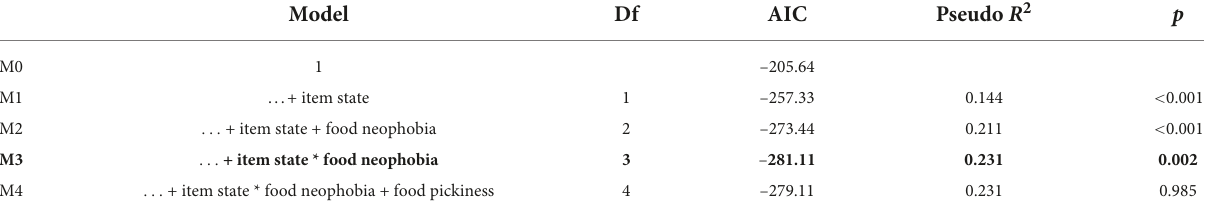
TABLE 6 The goodness of fit of the linear mixed-effects models with Beta as the outcome